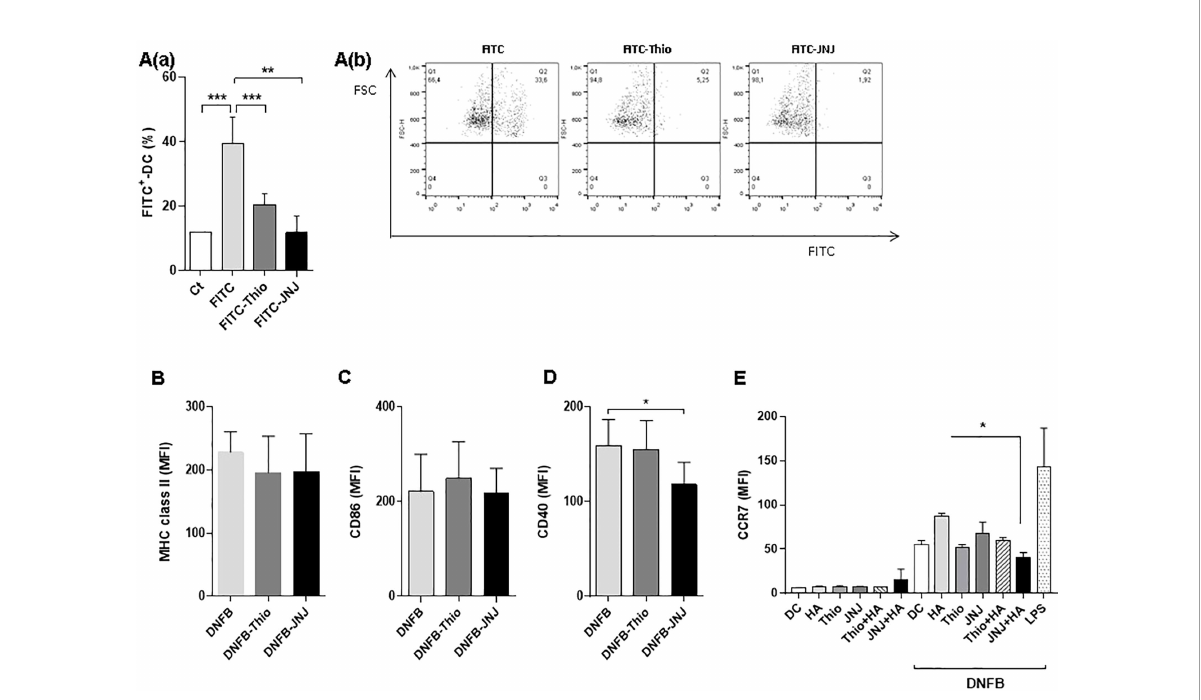
FIGURE 5 Analysis of migration of CD11c + IAd + dendritic cells (DCs). Mice were treated topically with a 1% FITC solution with or without different inhibitors. The mean ± SEM FITC-labeled DCs recovered from zonal lymph nodes after 24 hours of application are shown ( A , panel a). **p > 0.01,***p < 0.001. ANOVA with Tukey ’ s post-test ( n = 4). Representative dot plots of each treatment are shown ( A , panel b). The expression of MHC class II molecules (IA d ; B ), CD86 (C) , and CD40 (D) in DCs puri fi ed from mice treated topically with DNFB is shown. (E) Expression of CCR7 in DCs after 24 hours of stimulation in vitro (100 µg/ml DNFB). Bars represent the mean fl uorescence intensity (MFI). * p < 0.05. ANOVA with Tukey ’ s post- test ( n =